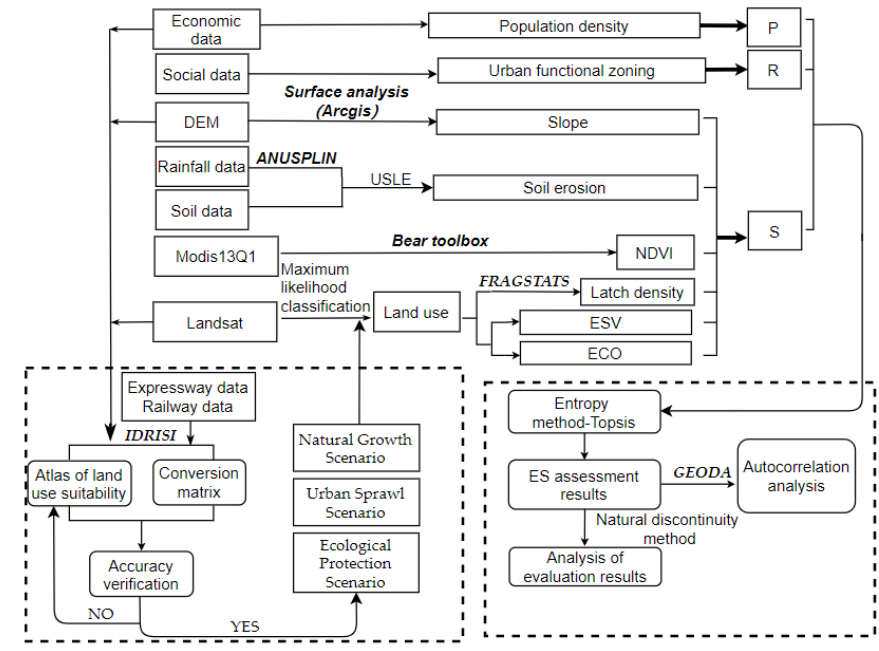
Figure 2. Technical flowchart.